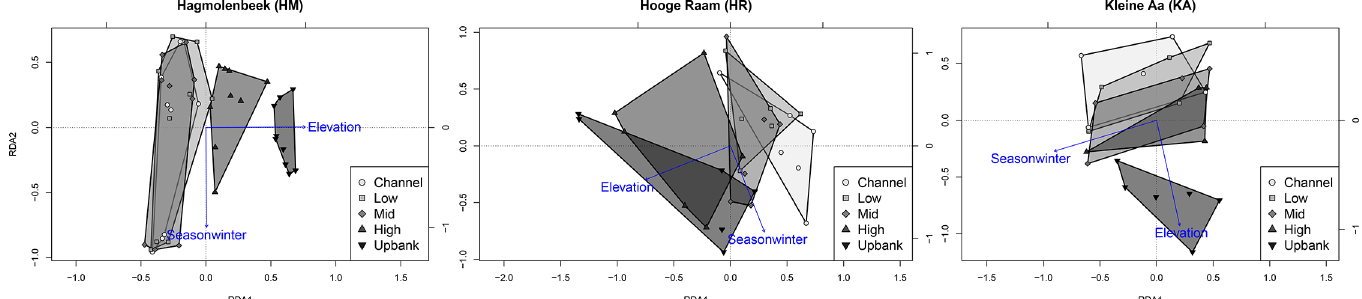
Fig 5. Distance triplots of partial redundancy analyses on Hellinger-transformed seed deposition per researchlocation with respectto the explanatory variables season and seed trap elevation. Site scores are indicatedby symbols, with symbol type determinedby seed trap positionalong the ripariangradient, rangingfrom the dry end (upbank)to the wet end (channel) of the riparian gradient. Contourlines are added aroundsites scores with the same symbol type.